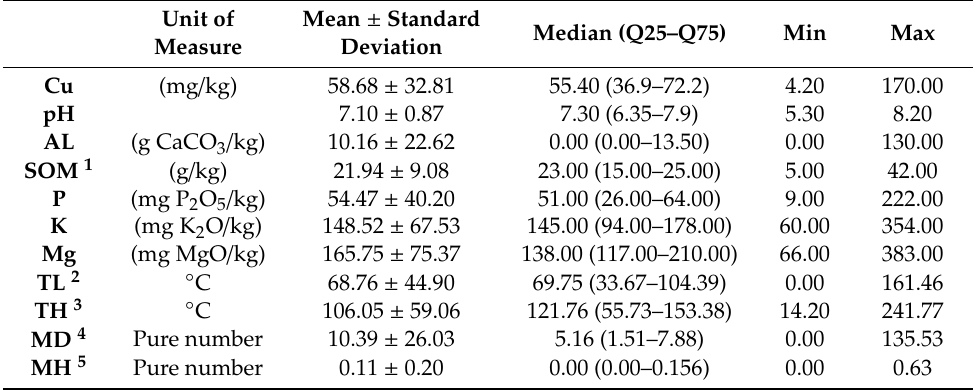
Table 1. Descriptive statistics of continuous variables (soil characteristics and environmental drivers) included in the analysis.